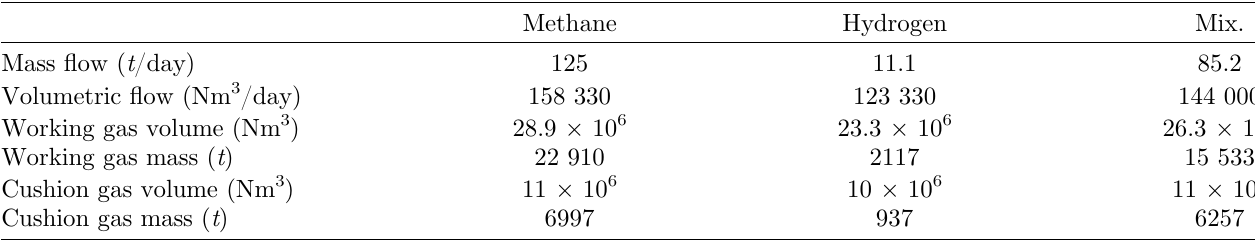
Table 1. Working and cushion gas